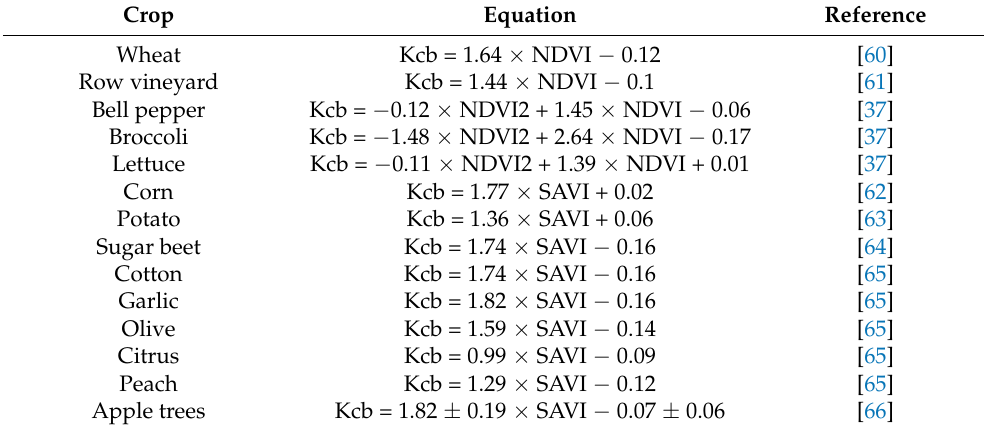
Table A1. Compilation of Kcb–VI relationships as found in the literature.